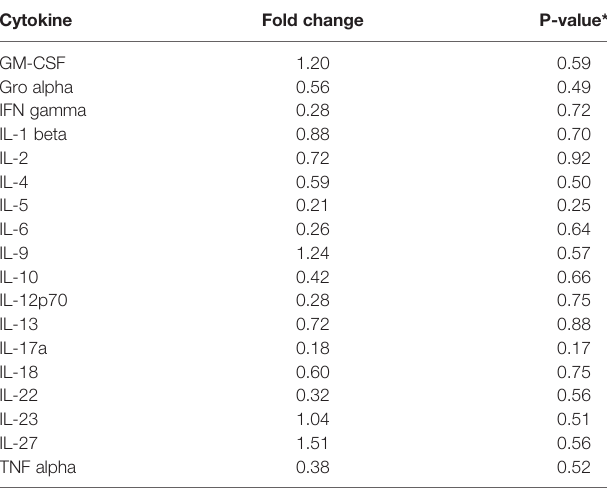
TABLE 2 | Median fold change in secretion of cytokines involved in Th1, Th2, Th9, and Th17 signaling from nonneoplastic colon tissue from Apc +/Min-FCCC vs . normal colon tissue from wild type mice.